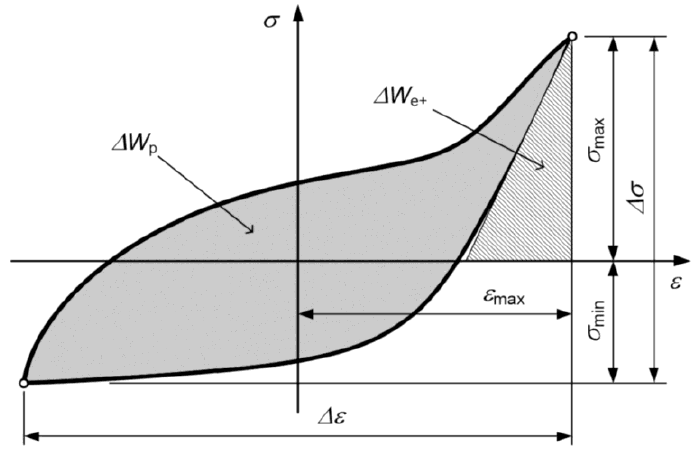
Figure 6. Typical elastic-plastic hysteresis loop of the AZ31 magnesium alloy; strain ε [-], stress σ [MPa].